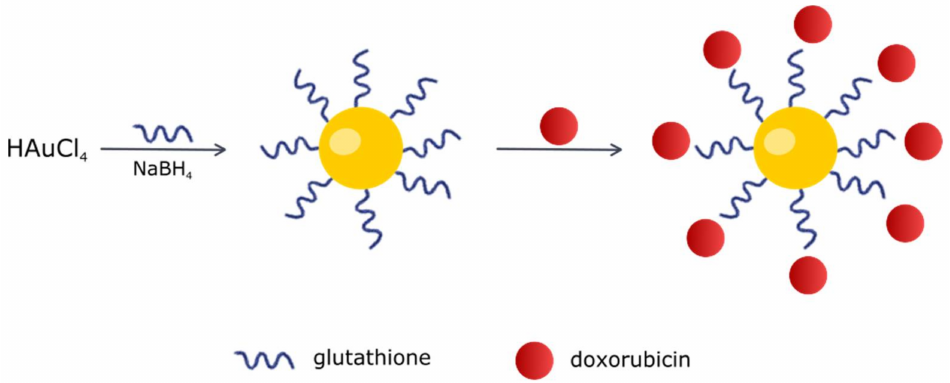
Figure 15. Scheme of Au-GSH-Dox